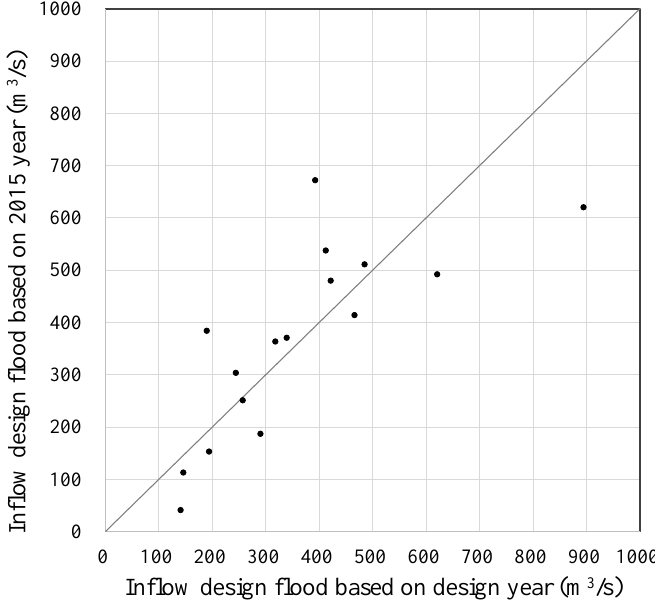
Figure 6. Scatter plot between the present inflow design flood and the inflow design flood based on 2015s (1986–2015) for a 200-y return period for 30 agricultural reservoir watersheds. The solid gray line is the 1:1 line.